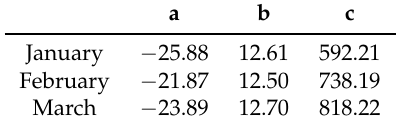
Table 2. Parameters in WF.